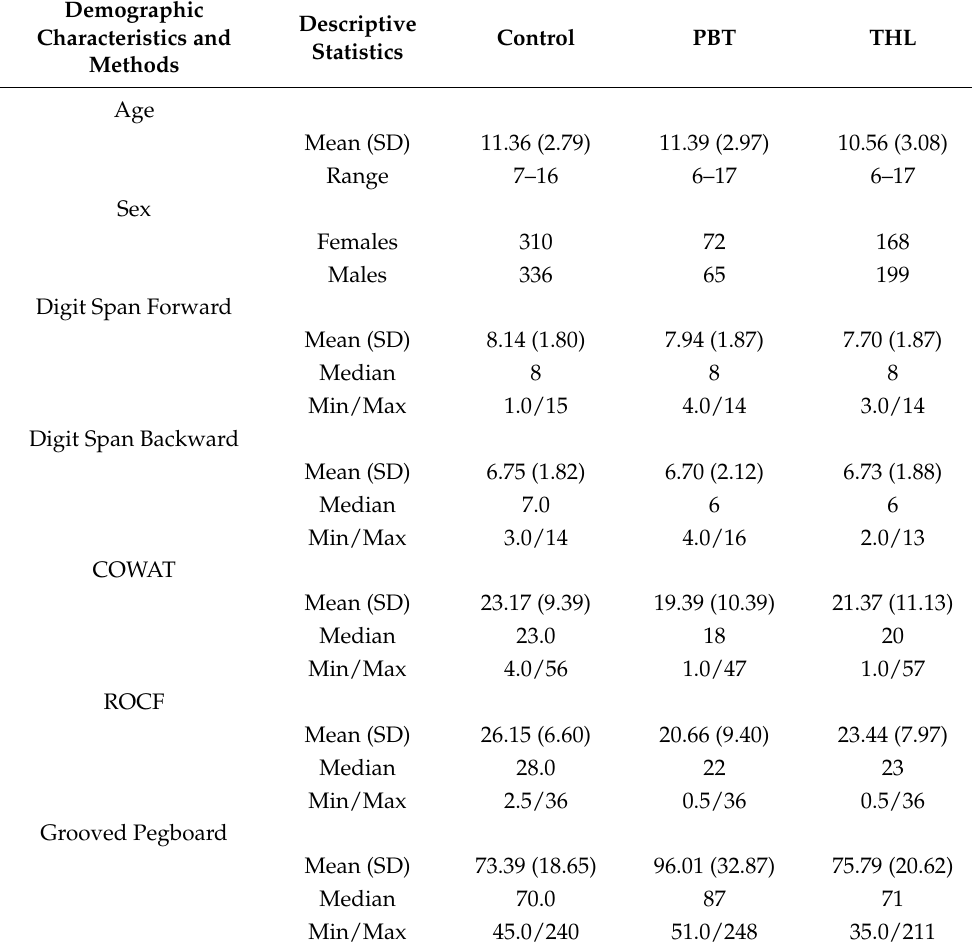
Table 1. Descriptive statistics of demographic characteristics and neurocognitive test scores of healthy controls ( n = 646), pediatric brain tumor survivors ( n = 137), and hematopoietic and lymphoid tissues tumor survivors ( n =